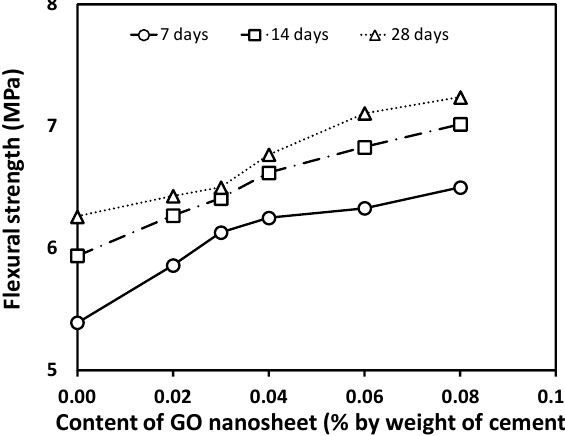
Figure 6. Flexural strength of concrete containing varying GO content.